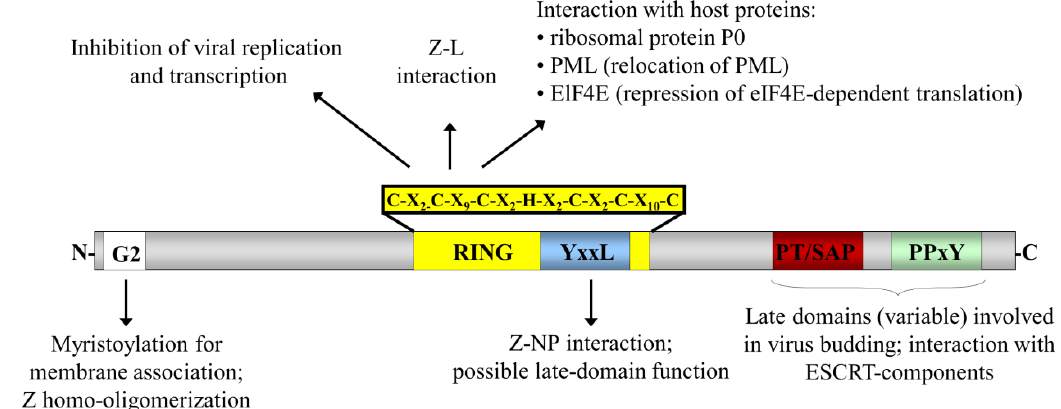
Figure 2. Schematic representation of the arenavirus Z protein and the domains important for its interactions and functions. The locations of the various functional domains in Z are indicated. The site of a myristoylated glycine residue at amino acid position 2 (G2) is indicated as a white box and the RING domain is indicated in yellow with the sequence of this domain indicated above. The various late domain motifs are indicated in colour: PT/SAP (red) and PPxY (green), as well as a putative late domain YxxL (blue). Known interaction partners and the functional roles for these domains are also